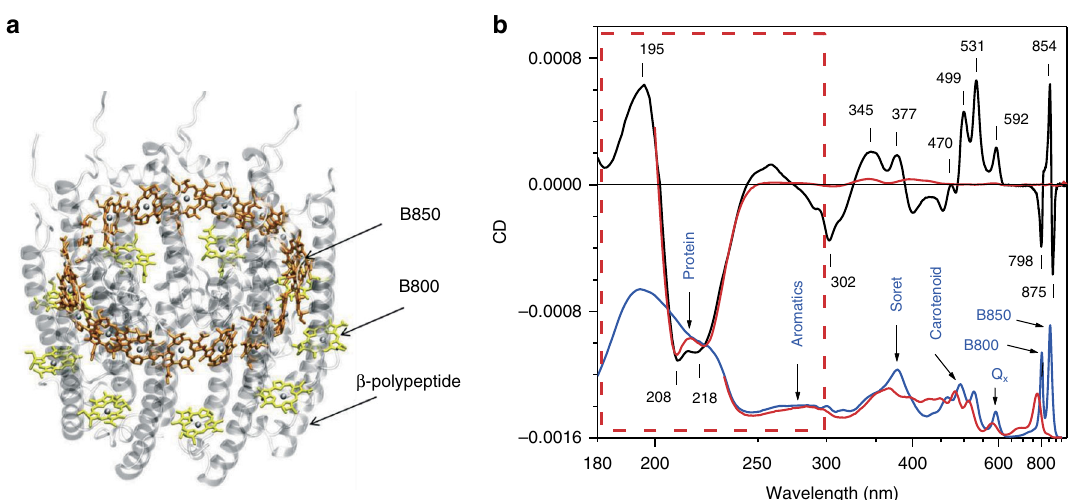
Fig. 1 Structure and optical spectra of the LH2 complex from Rhodoblastus acidophilus . a Simpli fi ed structure of the LH2 complex emphasizing cyclic arrangement of the BChl pigment chromophores and α – helical secondary-structure conformation of transmembrane polypeptides. For clarity, carotenoid molecules are left out and only half of the polypeptides ( β -) are presented. © aegon/Wikimedia Commons/GFDL and CC-BY-SA, with modi fi cations. b CD (black line) and absorption (blue line) spectra of the isolated LH2 complex at 20 °C. Reciprocal (linear in energy) wavelength scale is used. Numbers at corresponding vertical lines indicate the positions of the CD spectral lines in nanometers. The area surrounded by the dashed red line delineates the protein range. The absorption spectrum with optical density of 0.58 at 858 nm was multiplied by a factor of 1.2 × 10 − 3 and shifted vertically to show absorption and CD spectra in one fi gure. Shown by red line are the corresponding CD and absorption spectra measured at 20 °C after heating up the sample to 70 °C